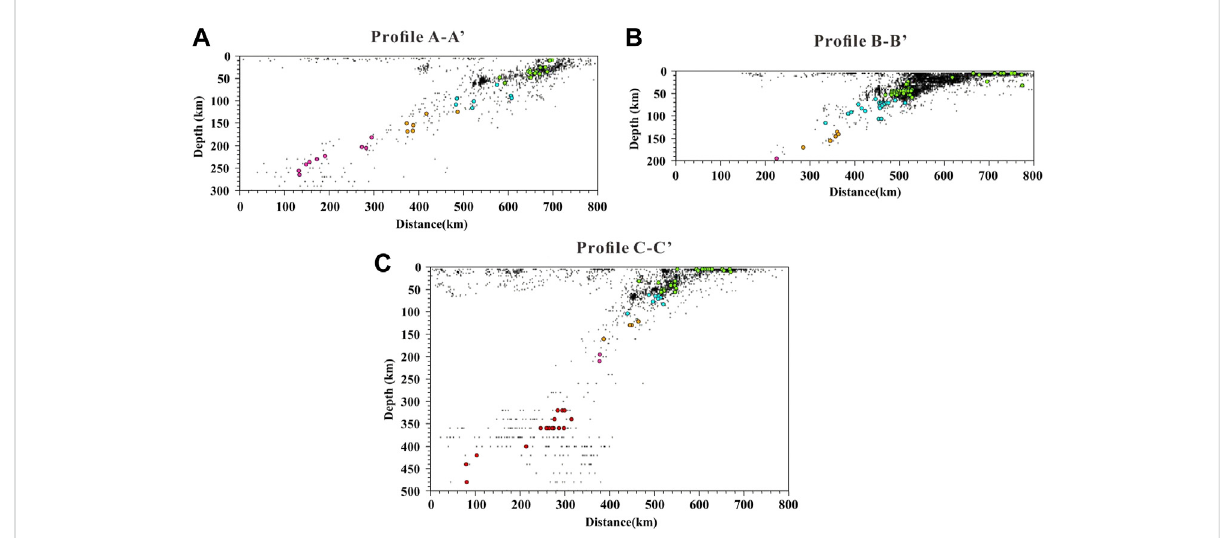
The distribution of earthquakeson Pro fi le A-A ’ (A) , B-B ’ (B) and C-C ’ (C) . The seismicity from the Japan Meteorological Agency (JMA) catalogue is denoted by the small black dots for a period from 2012 – 2021. The larger dots represent the events that we selected for the focal mechanism calculation in this study. The color of these dots indicates the source depth which is consistent with Figure